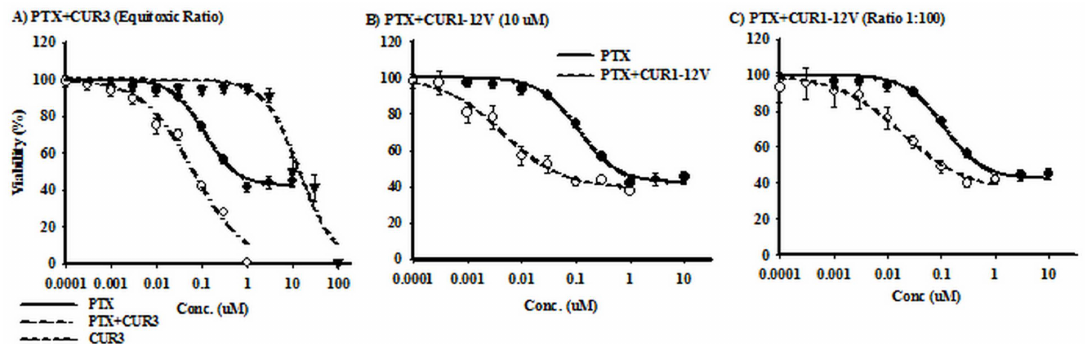
Fig 6. The effect of serial equitoxic concentrations (ratio 1:100) of Cur3 (A), and 10 μ M (B), and serial concentration of Cur1-12V (ratio 1:100) (C) on the cytotoxicity of PTX in HCT-116 cells. Cells were exposed to serial dilutionof PTX ( ● ), Chemosensetizer( ▼ ) or their combination ( ○ ) for 72 h. Cell viabilitywas determinedusing SRB assay.